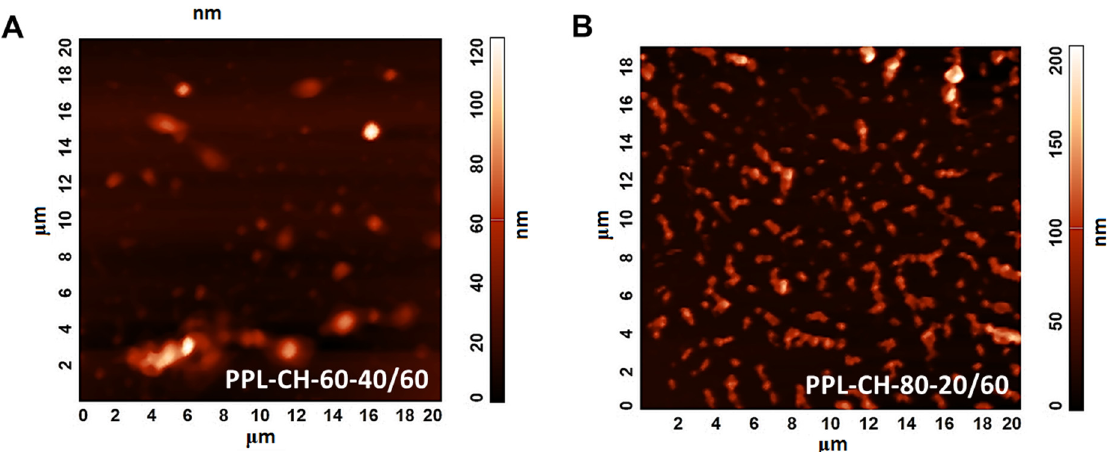
Figure 6. Atomic force microscopy images taken of the liposome samples prepared from PC-CH 60:40 ( A ) and 80:20 ( B ) mass ratio compositions at 60 °C, and hydrated with saline solution.